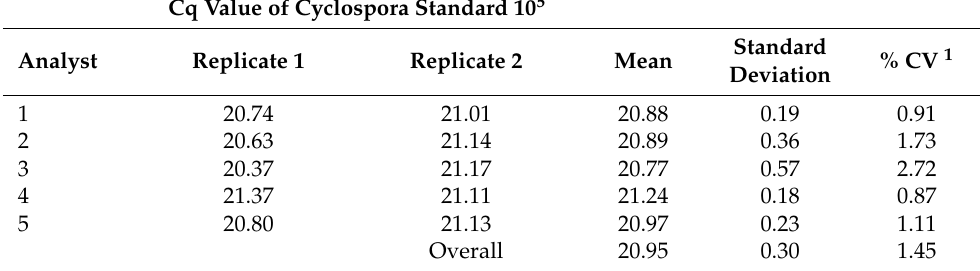
Table 5. Cq values generated for the Cyclospora artificial positive control on five different plates conducted by five different